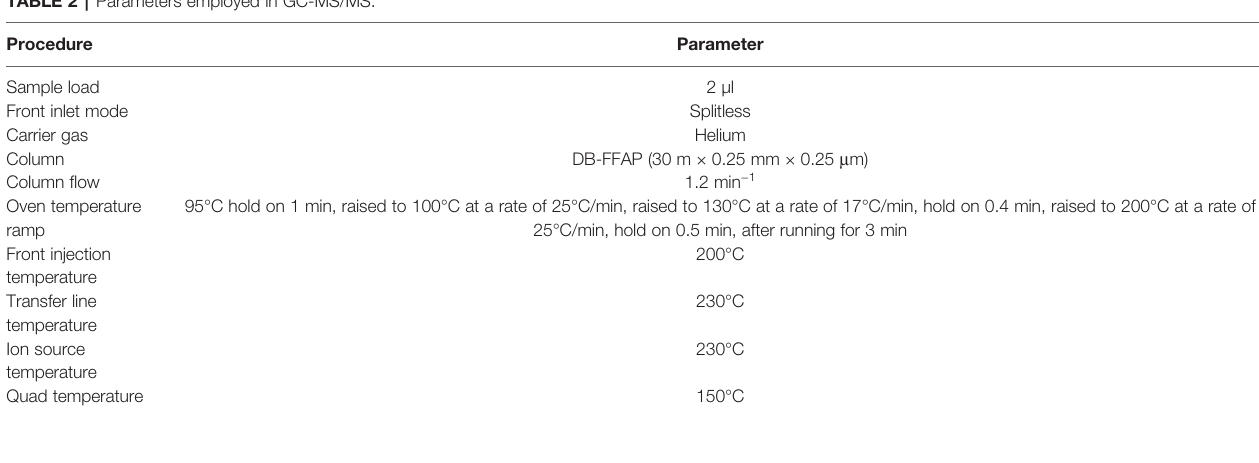
TABLE 2 | Parameters employed in